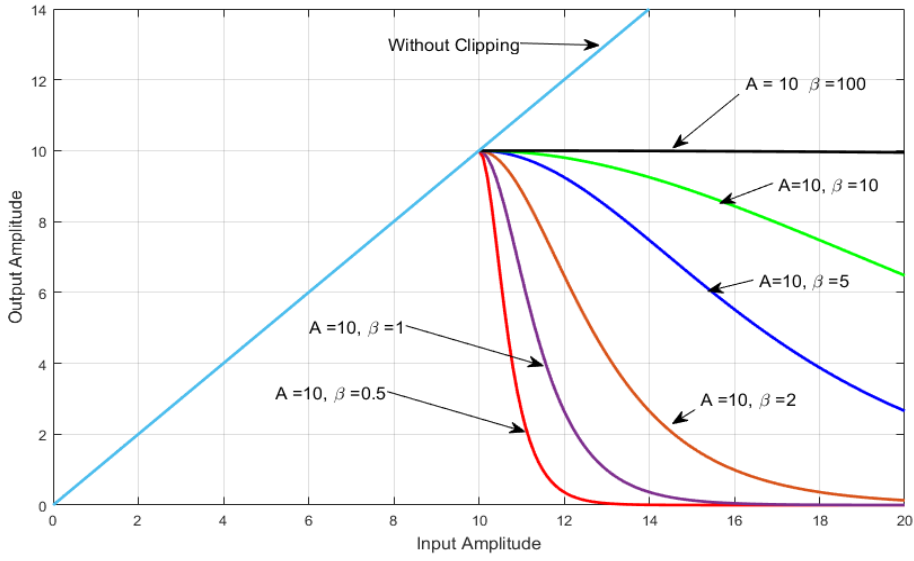
Figure 7. Palm clipping function 𝑃 𝛽𝐴 (𝑟) with A = 10 and the variable smoothness parameter 𝛽 .